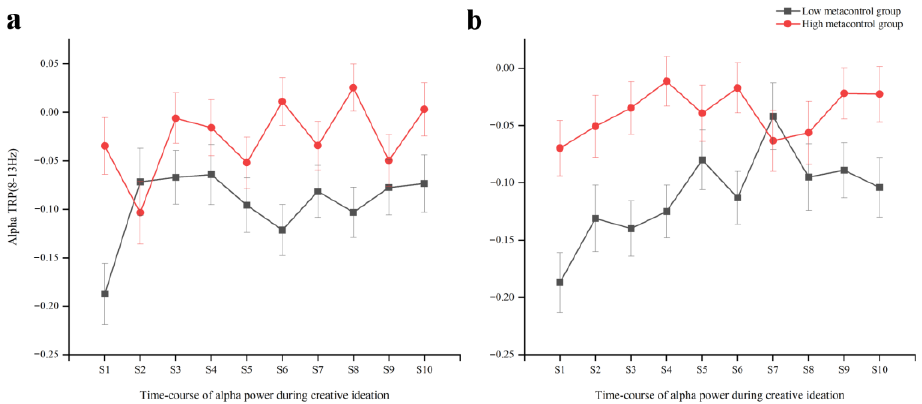
Figure 5. Means and standard error bars of task-related alpha power changes during the course of alternative uses task ( a ) and remote associates test ( b ). alternative uses task ( a ) and remote associates test ( b